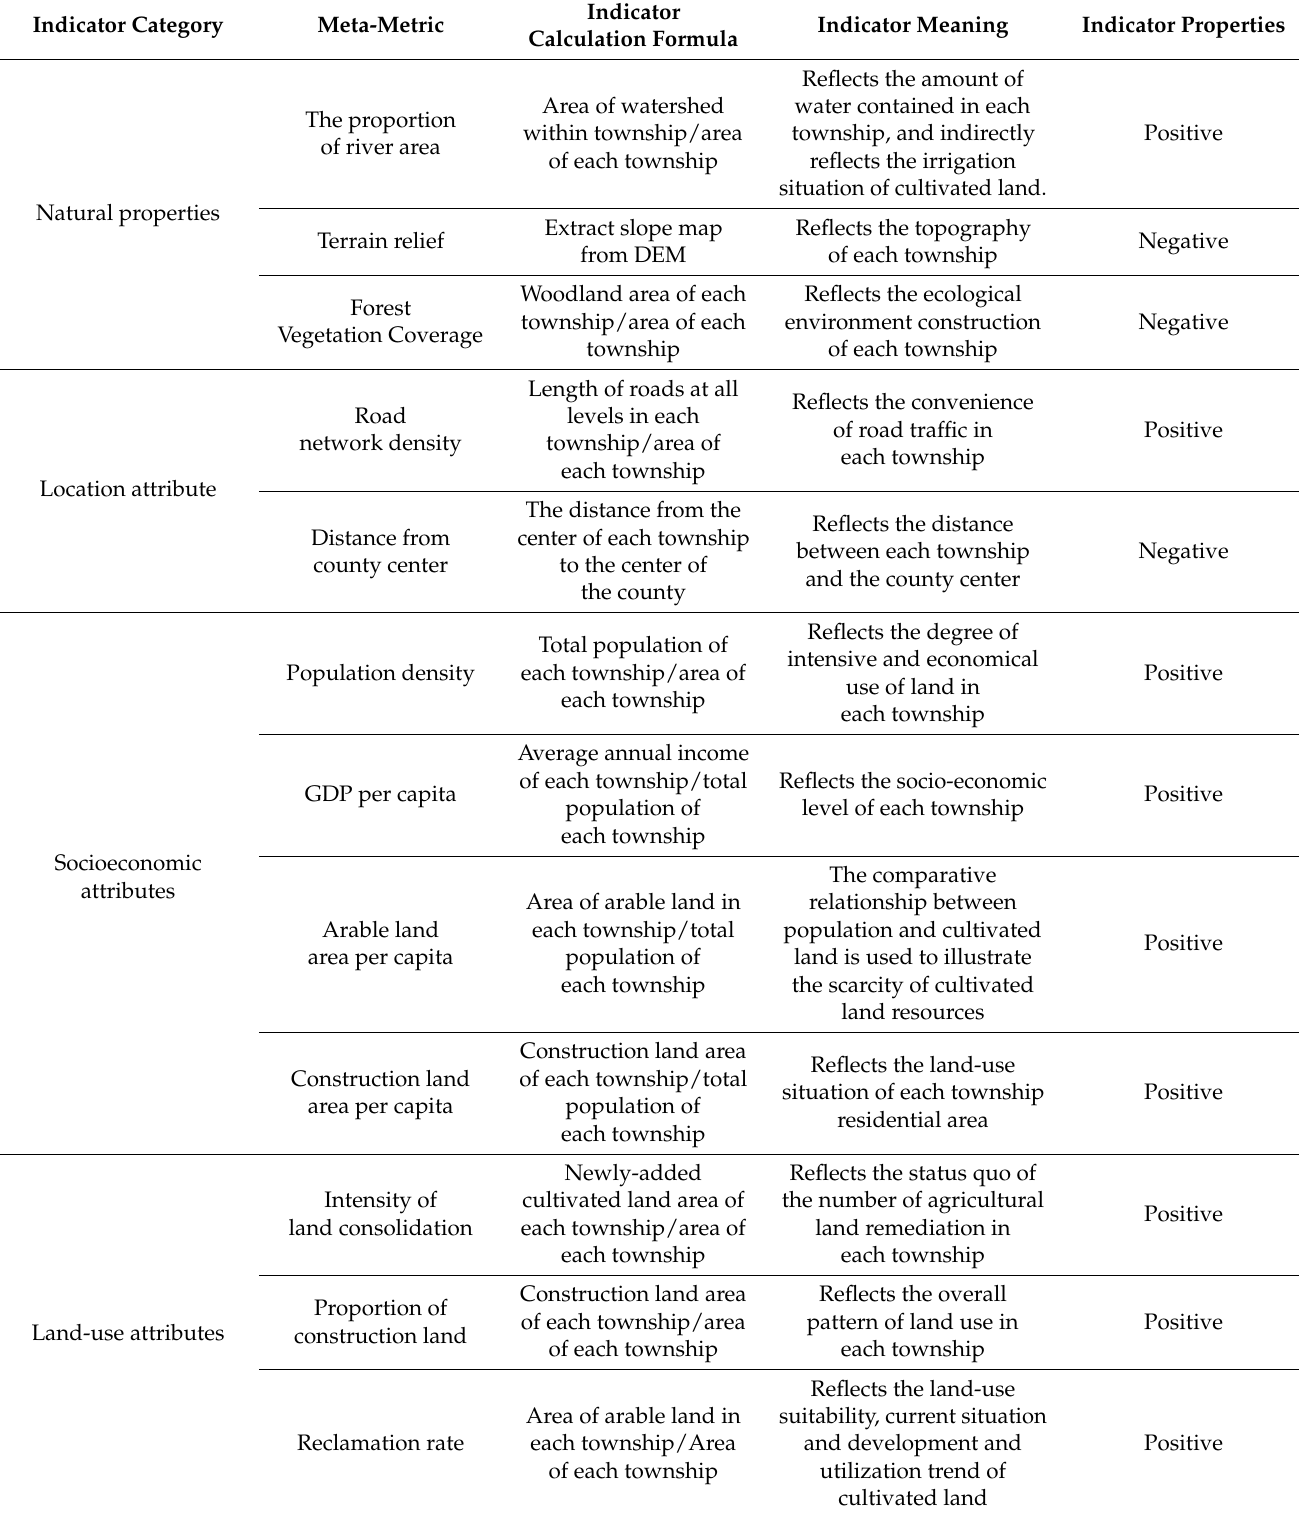
Table 1. Land comprehensive consolidation zoning index